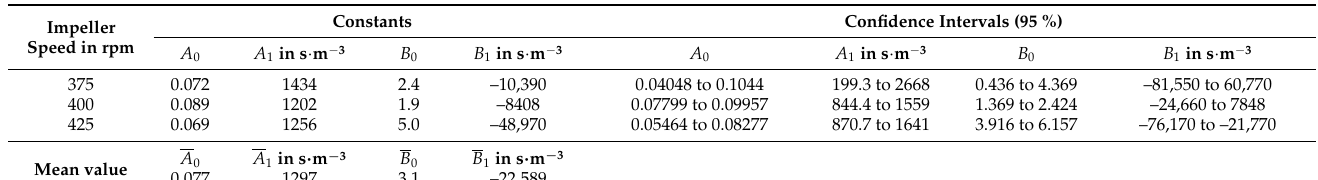
Table 3. Determined coefficients for Equation (9) at different impeller speeds, the mean values for Equation (10), and their corresponding confidence